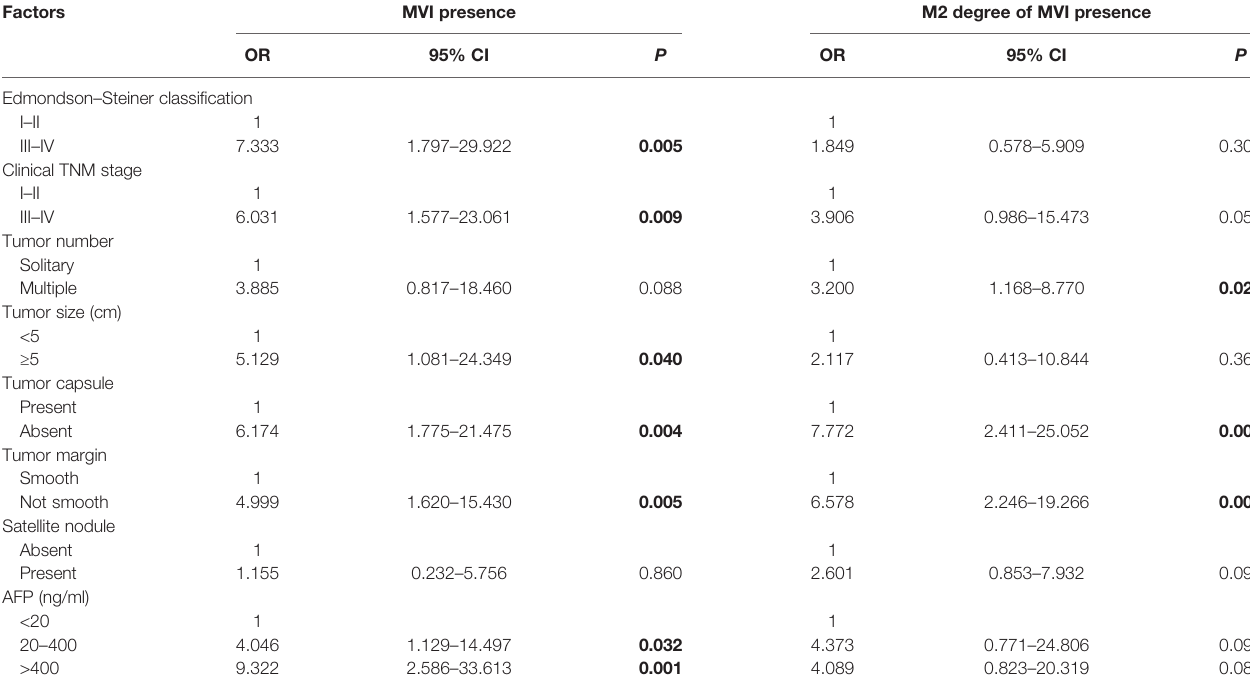
TABLE 3 | Risk factors for MVI and its M2 grade identi fi ed by logistic multivariate